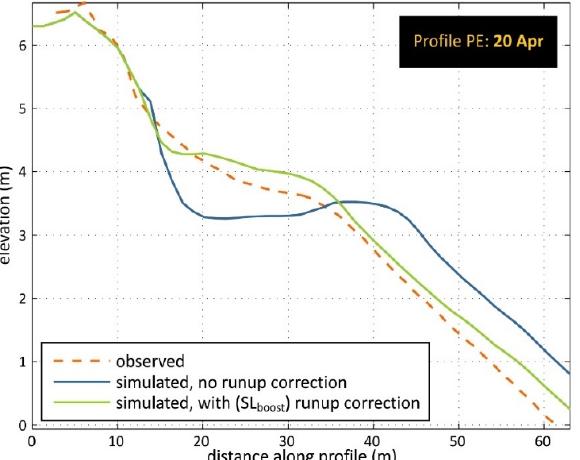
Figure A1. The influence of the SL boost correction to the simulated profile, shown for of PE at the end of the simulation period (20 April): Two simulated profiles (both use the calibrated values of facua and bermslope; Table 3) are shown, one with no correction for runup height (blue curve) and one after correction (SL boost ; green curve–same as Figure 8c) for profile PE.